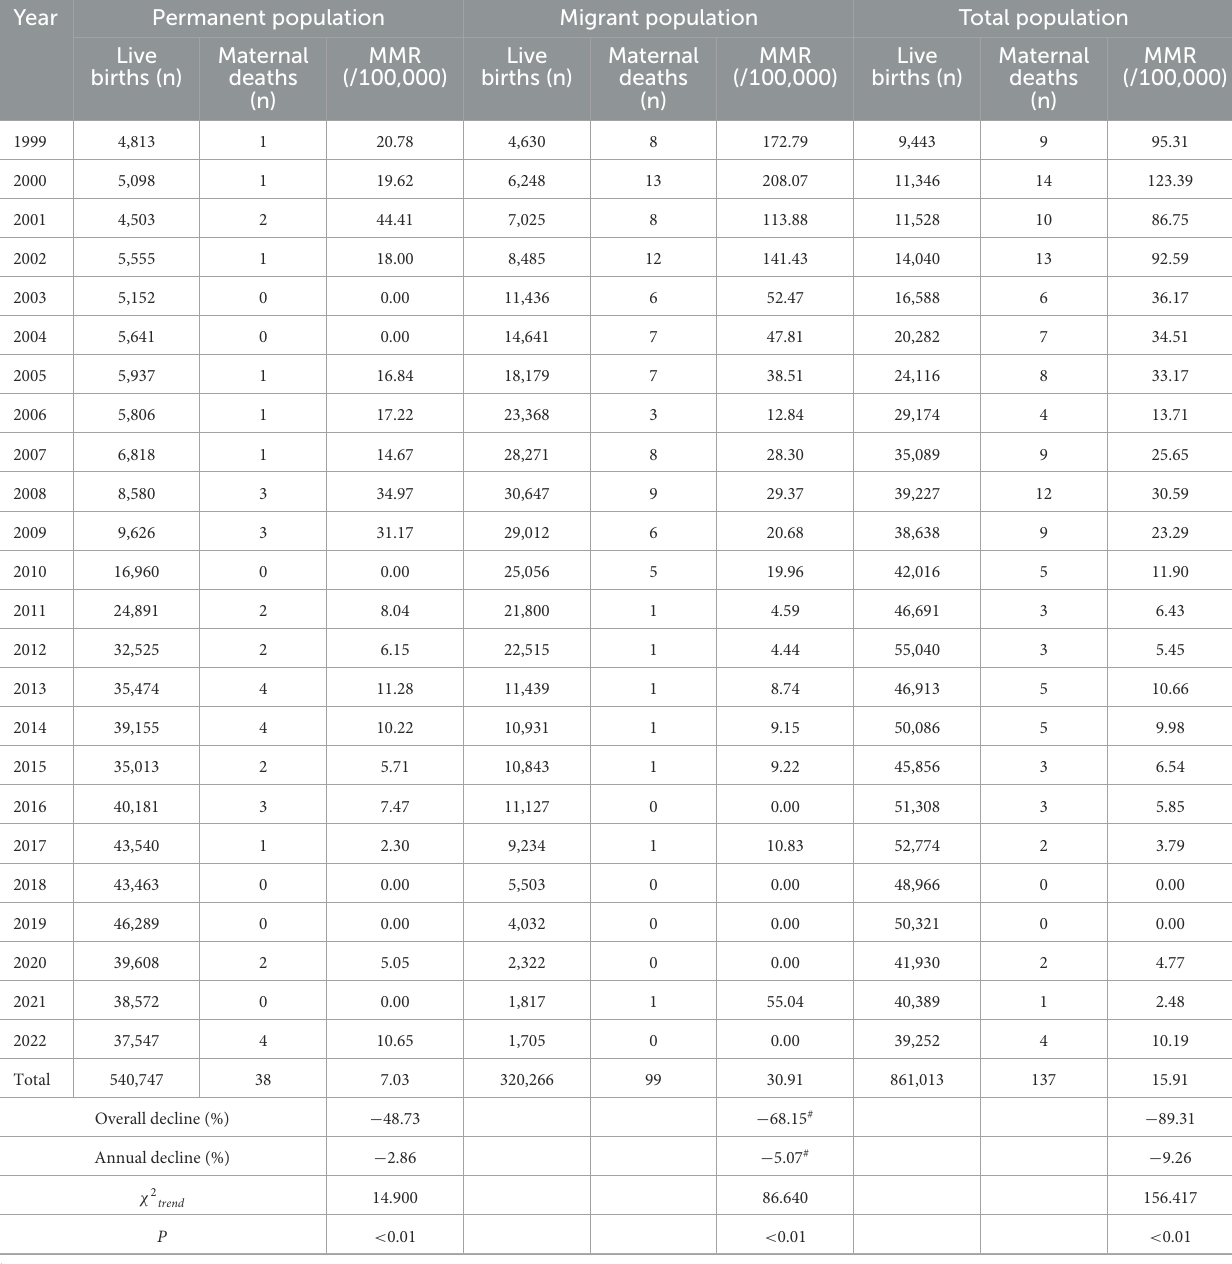
TABLE 1 The MMR in Baoan district, Shenzhen during